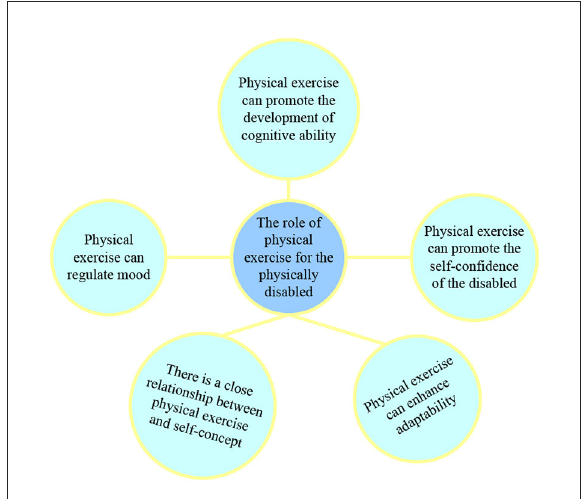
FIGURE1 The role of physical exercise for the physically handicapped.